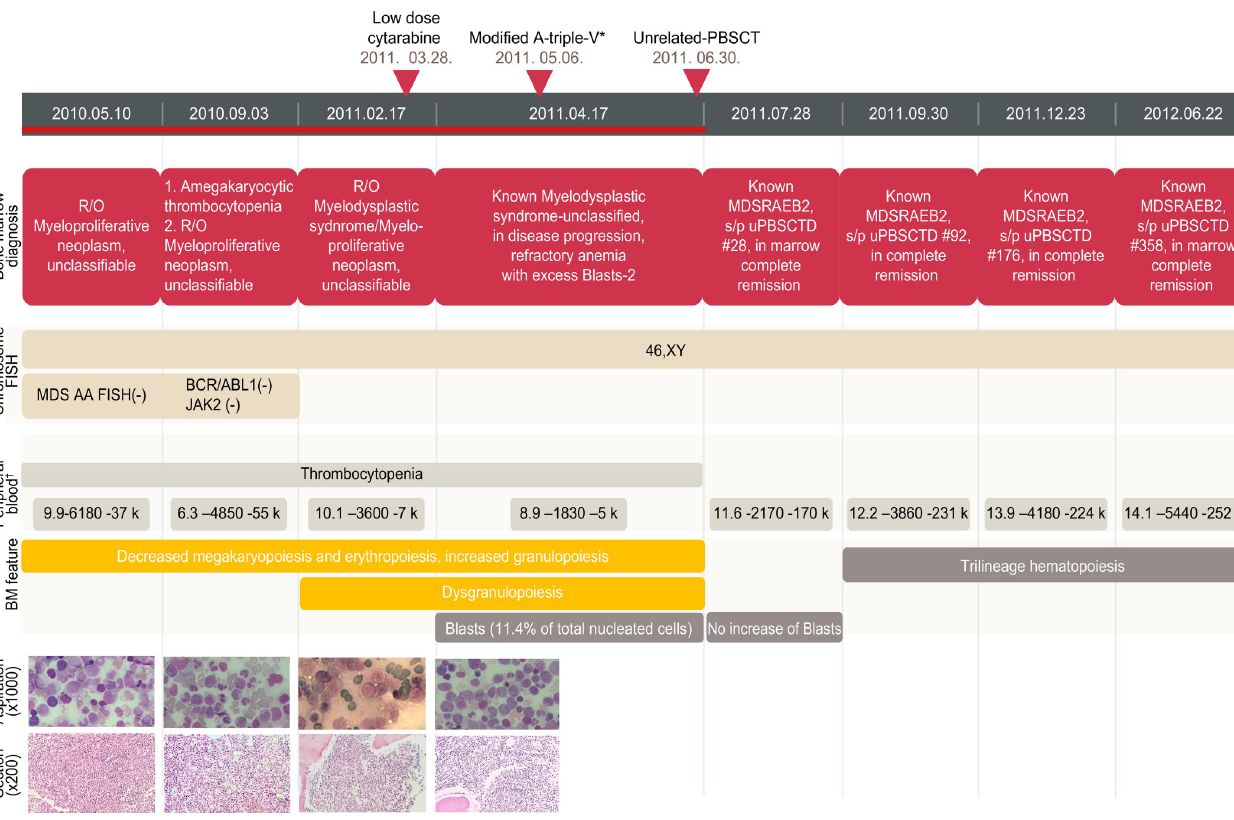
Fig 3. Clinical course of the patient 1: Eight consecutive BM examinations, cytogenetic studies, hemograms, and treatments. FISH, fluorescent in situ hybridization; BM, bone marrow; uPBSCT, unrelated peripheral blood stem cell transplantation; MDS, myelodysplastic syndrome; MDS-RAEB 2, myelodysplastic syndrome; refractory anemia with excess blasts-2. � Etoposide, cytarabine, vincristine, vinblastine. † Blood cell count shows hemoglobin ( × 10 3 /L), white blood cell count ( × 10 6 /L), and platelet count ( × 10 6 /L) in that order.